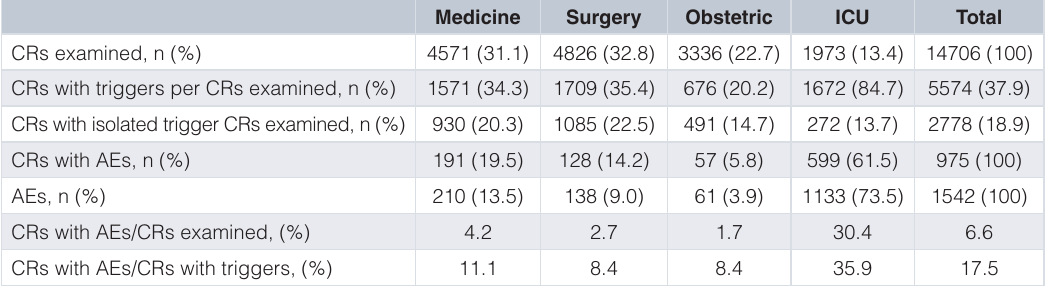
Table 1. Distribution of CRs per clinical